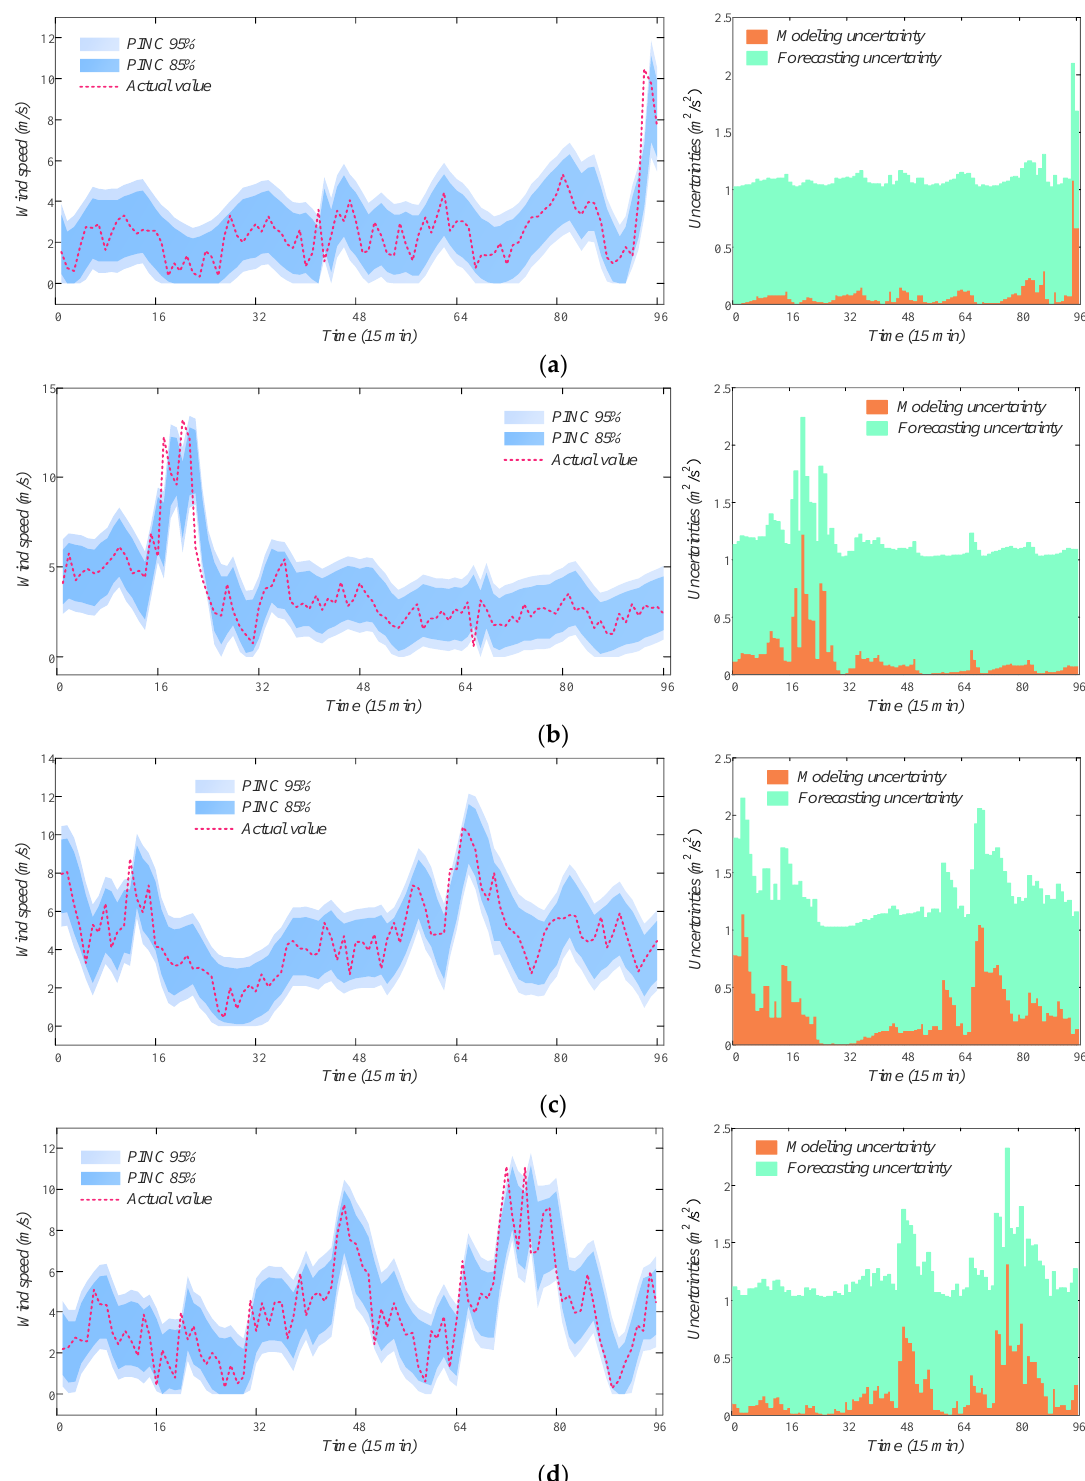
Figure 12. The prediction intervals of 1-step-ahead probabilistic wind speed forecasting using WTD-RNN-ANFIS. ( a ) Spring; ( b ) summer; ( c ) autumn; ( d ) winter.